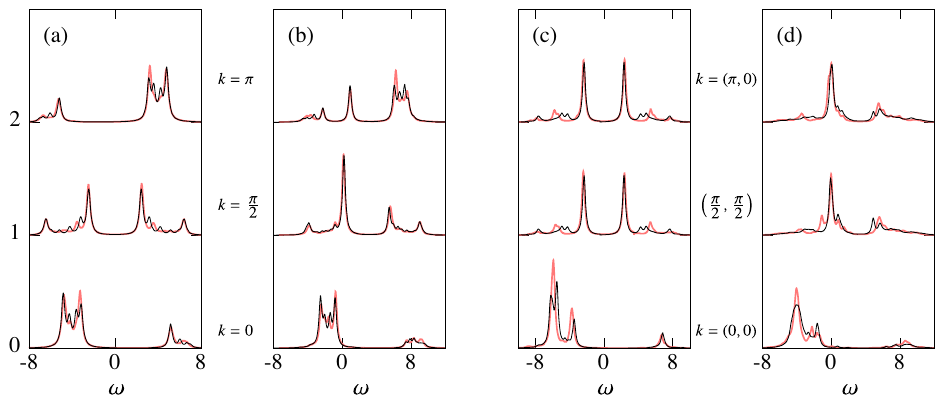
FIG. 9. Comparison of spectral weight for the 64-site 1D Hubbard model at 12.5% hole doping, as shown in Fig. 3(c), but considering only a subset of excitations. Details are the same as in Fig. 8.